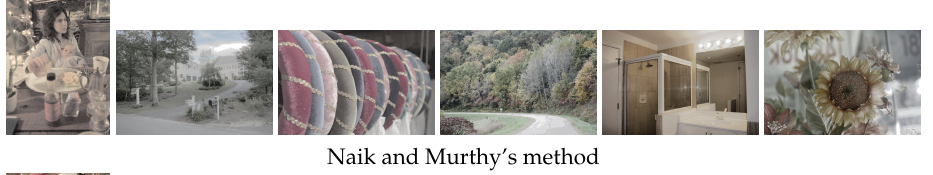
Figure 13. Histogram equalization applied to color images in Figure 12, where the top, middle and bottom rows show the output images by Naik and Murthy’s, Yang and Lee’s and the proposed methods, respectively.